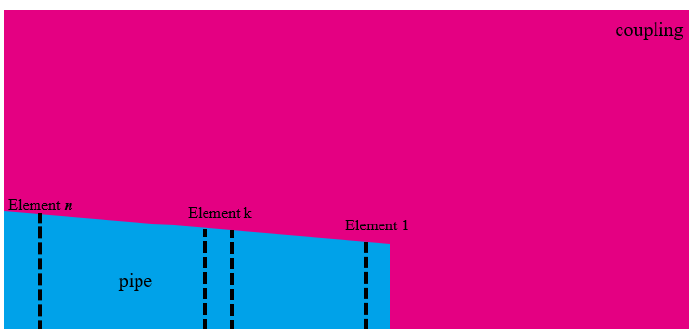
Figure 6. Axial sealing contact element of cone-to-cone sealing structure for premium connections.